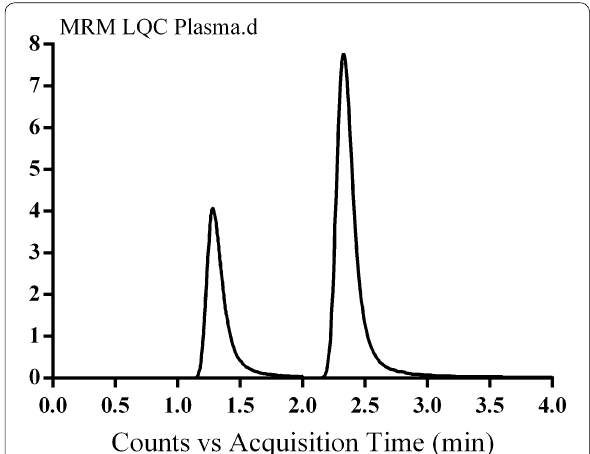
Fig. 4 Overlayed MRM chromatogram of VNT LQC in plasma and blank plasma showing no interference from plasma matrix